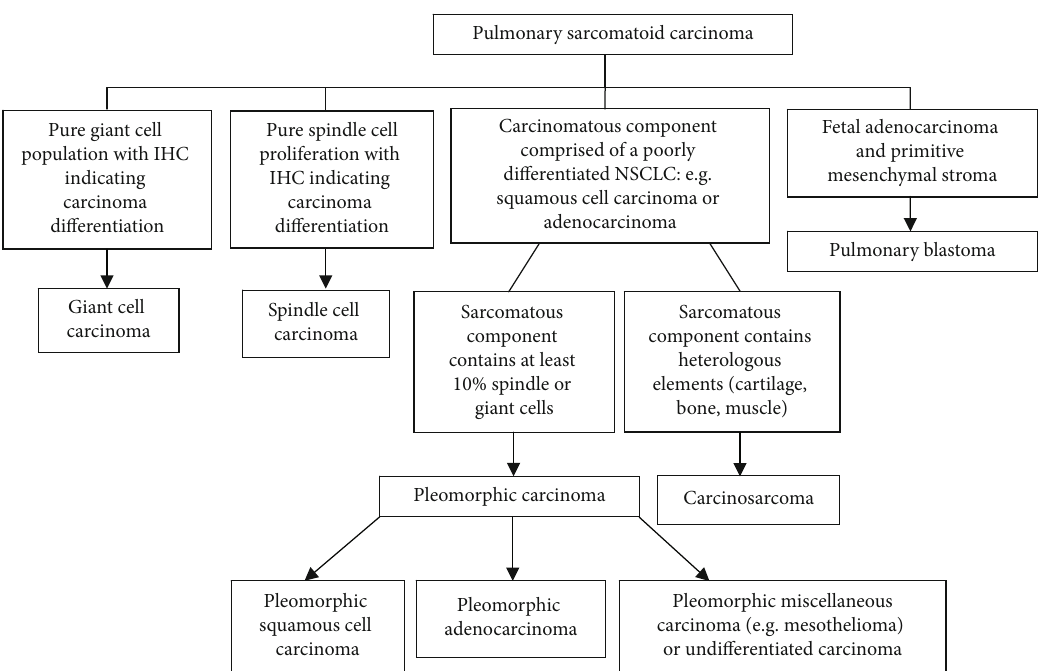
Figure 1: WHO classi fi cation of mixed pulmonary tumors. Pulmonary sarcomatoid carcinomas have fi ve subtypes, the di ff erentiating features of which are listed here. Note that the primary di ff erentiating feature between “ carcinosarcoma ” and “ pleomorphic carcinoma ” is the presence of heterologous elements within the sarcomatous component of the carcinosarcoma. In human beings, sarcomatous components such as leiomyosarcoma, osteosarcoma, rhabdomyosarcoma, chondrosarcoma, liposarcoma, and angiosarcoma have been documented [3]. IHC: immunohistochemistry; NSCLC: non-small-cell lung